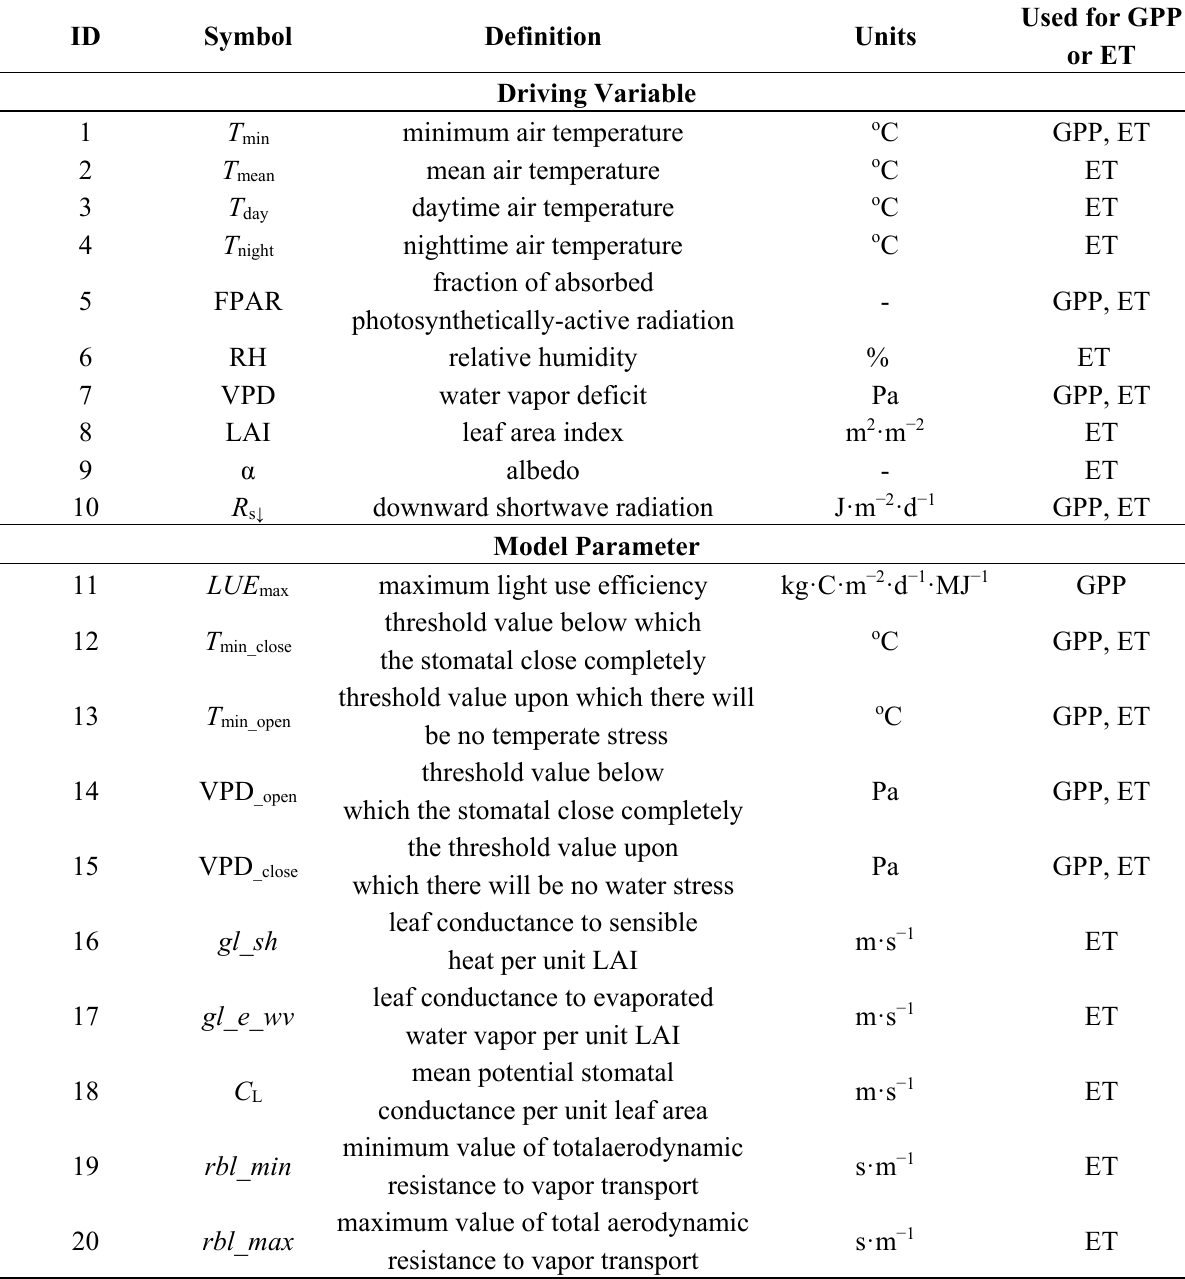
Table 2. Input driving variables and model parameters in the MODIS gross primary production (GPP) and evapotranspiration (ET)